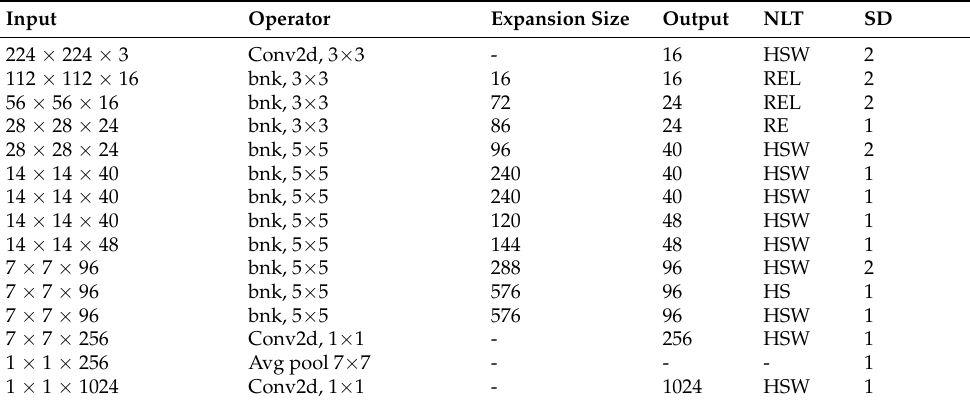
Table 3. Parameter for the proposed depthwise separable convolution. bnk represents bottleneck convolution. NLT stands for the kind of nonlinearity adopted. HSW represents h-swish. REL denotes ReLU and SD represents